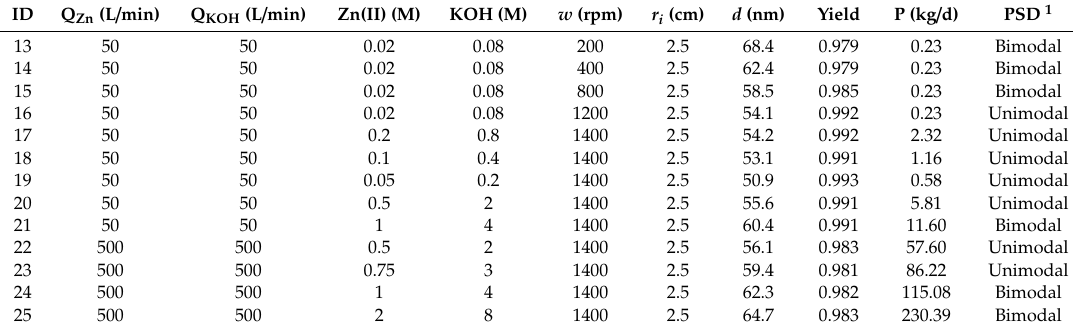
Table 3. Results obtained in the remaining 13